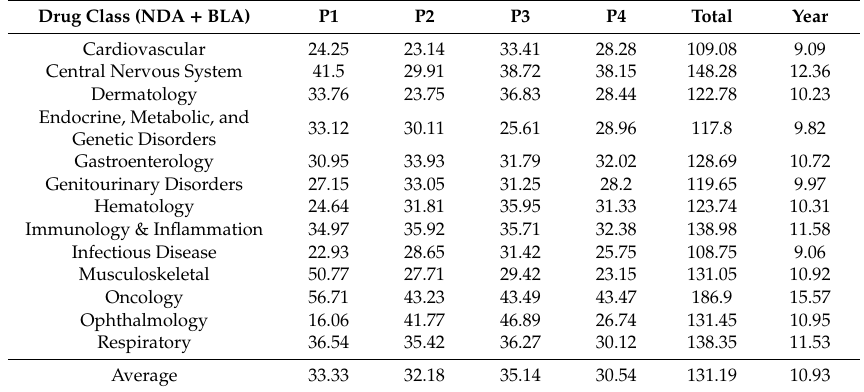
Table 9. Development period (month) of new drugs in each drug class / phase for the whole period (1970–2017).